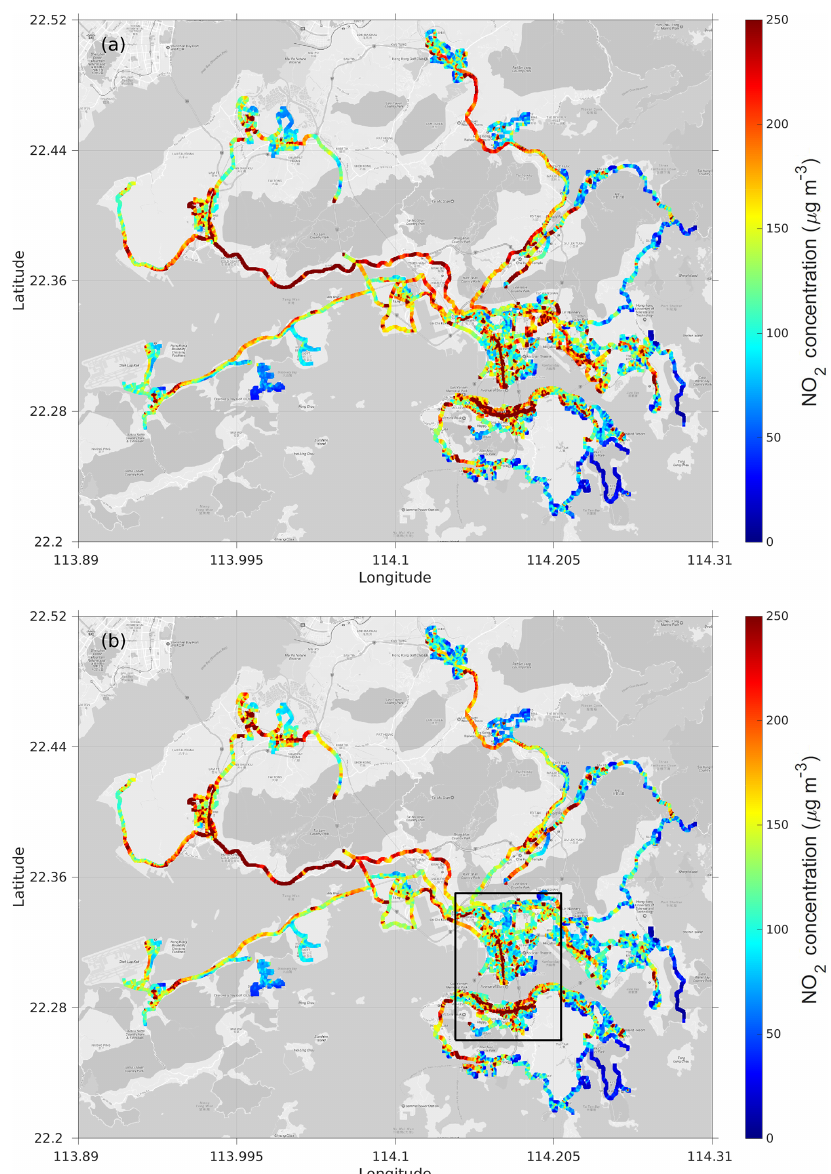
Figure 12. (a) Averaged spatial distribution of NO 2 in Hong Kong measured by the mobile CE-DOAS in 2010. (b) Normalized spatial distribution of NO 2 over Hong Kong measured by the mobile CE-DOAS in 2010. The CE-DOAS data are normalized using coinciding normalized LP-DOAS data. The black box indicates the area of the city centre used for the other maps. The standard route measurement was taken 3 times per day, while other locations only have a single or a few overpasses during the two